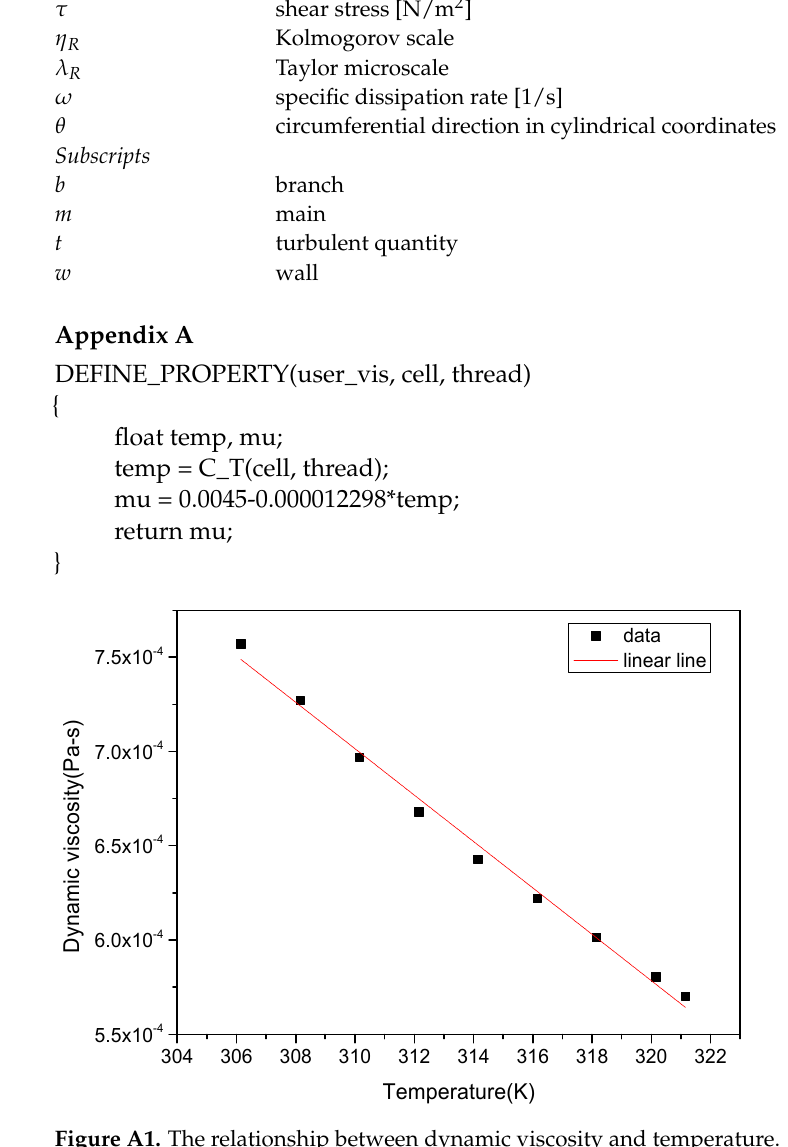
Figure A1. The relationship between dynamic viscosity and temperature.